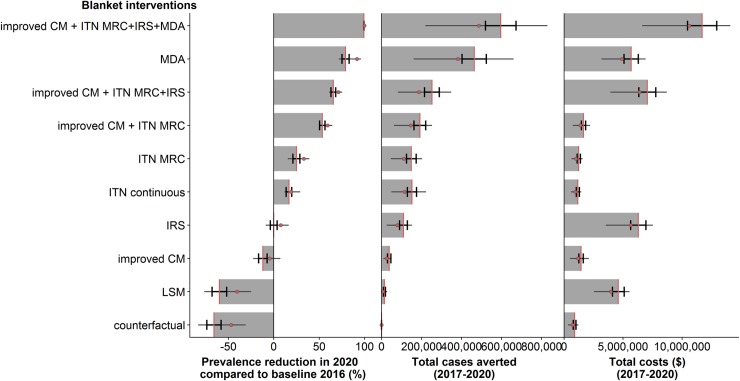
Simulated prevalence, cases averted and costs for single and incremental intervention scenarios from 2017–2020.The interventions scenarios shown visualise blanket distributions, with the same intervention scenario for all councils. The vertical lines indicate the confidence interval around the mean (red line), the red point the median, and the horizontal lines the 50% interquartile range between councils.